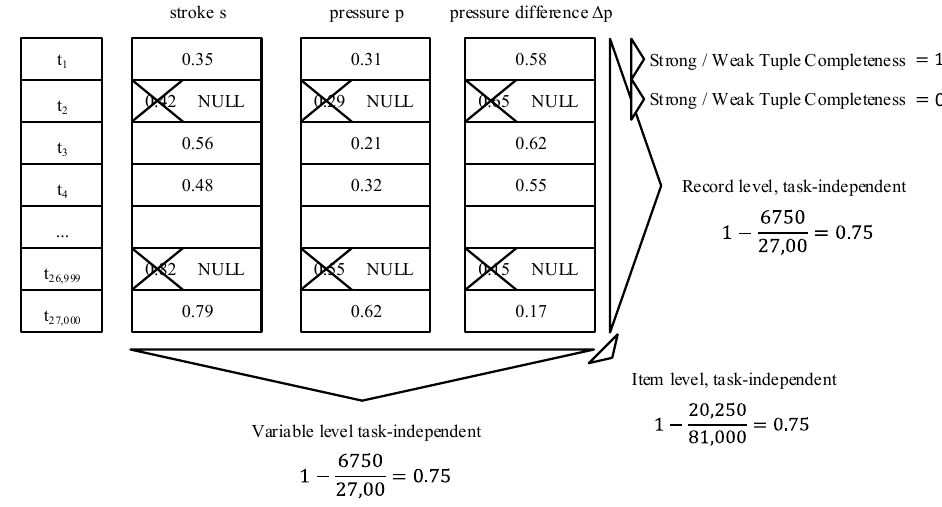
Figure 13. Descriptive statistics of the original data set and the manipulated data sets A and B ( left ) and histograms and boxplots of the respective data sets ( right ).